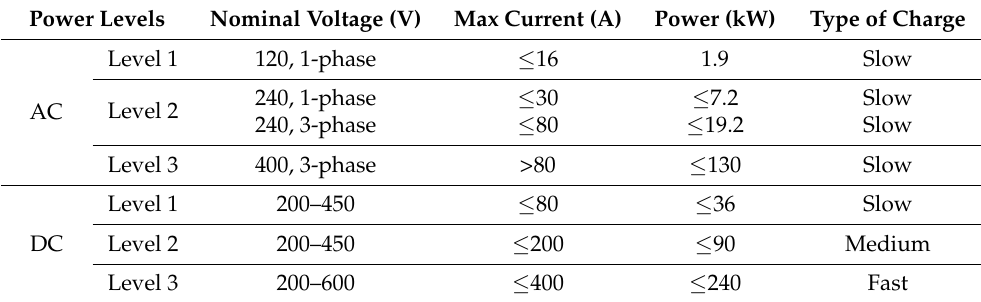
Table 2. AC and DC Charging Power